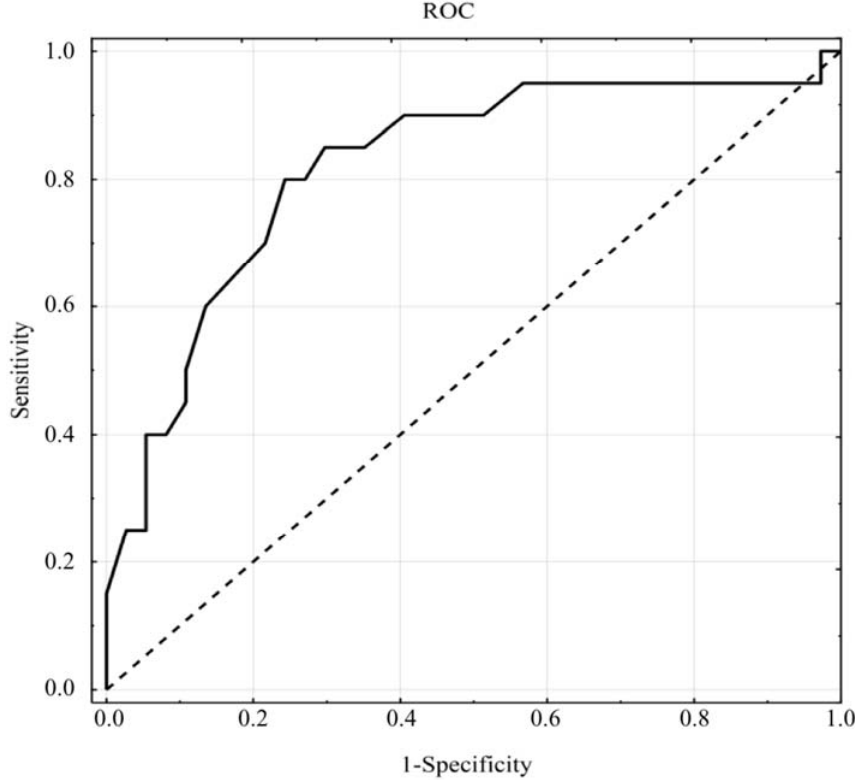
Figure 1. Receiver operating characteristic (ROC) curves of HbA1c for the prediction of female sexual dysfunction.